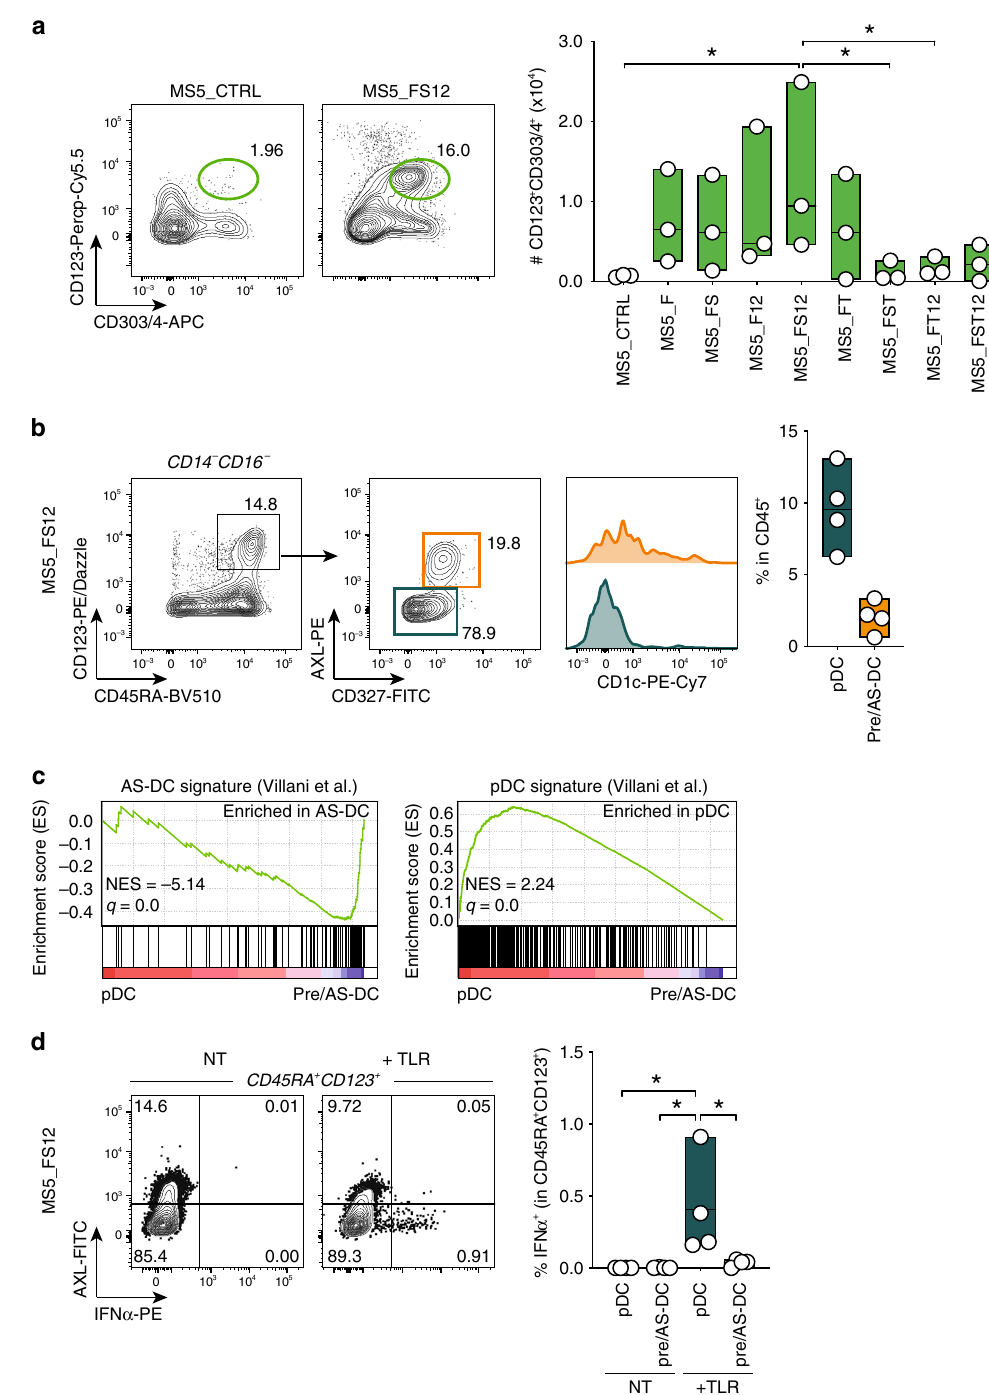
Fig. 3 MS5_FS12 stromal cells support pDC and pre/AS-DC development in vitro. a Representative FACS plots and absolute number of CD123 + CD303/ 4 + cells generated in vitro from CD34 + HSPCs co-cultured with MS5 expressing human FLT3L (MS5_F) in combination with human SCF (S), TPO (T), and CXCL12 (12). Day 15 fl ow cytometry analysis of n = 3 cord blood donors in three independent experiments. * p < 0.05, one-way ANOVA test with Tukey ’ s multiple comparisons. b Gating strategy used to identify AXL − CD327 lo/ − pDC and AXL + CD327 + pre / AS-DC within CD123 + CD45RA + cells generated in vitro using MS5_FS12. Graph illustrates the frequency of each subset in CD45 + cells ( n = 4 cord blood donors). c GSEA comparing in vitro-differentiated pDC and pre/AS-DC using published human pDC and AS-DC gene signatures 20 (FDR false detection rate, NES normalized enrichment score). Statistical signi fi cance is de fi ned by the FDR q -value calculated by the GSEA software (www.broad.mit.edu/gsea) using default parameters. d Intracellular fl ow cytometry analysis of IFN α production in pDC and pre/AS-DC in response to 16 h of TLR stimulation (lipopolysaccharide (LPS) 10 ng/ml, R848 1 μ g/ml, Poly(I:C) 25 μ g/ml). Bar graph shows the frequency of IFN α + cells in each subset with ( + TLR) or without (NT) stimulation ( n = 4 cord blood donors). * p < 0.05, one-way ANOVA test with Holm – Sidak ’ s multiple comparisons. Data are presented as fl oating bars ranging from min to max and line represents median ( a , b , d